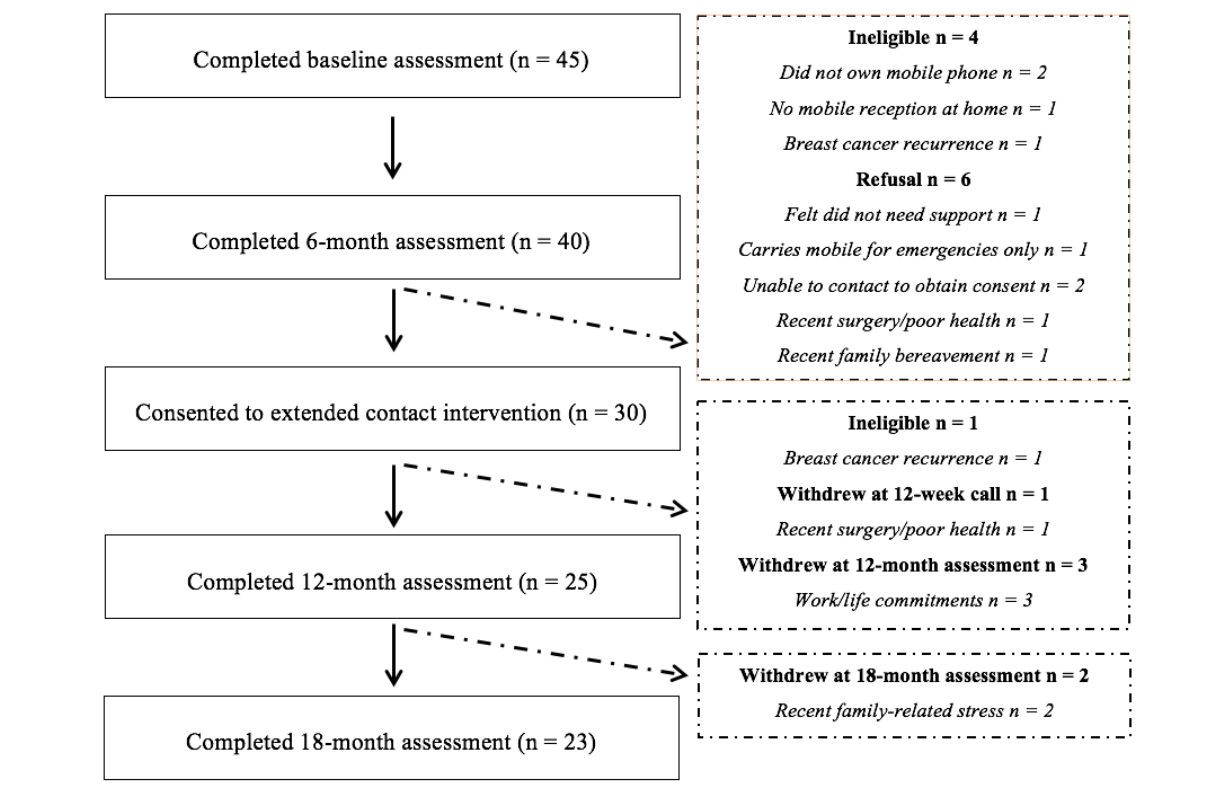
Figure 1. Flow of participants from baseline to the final 18-month